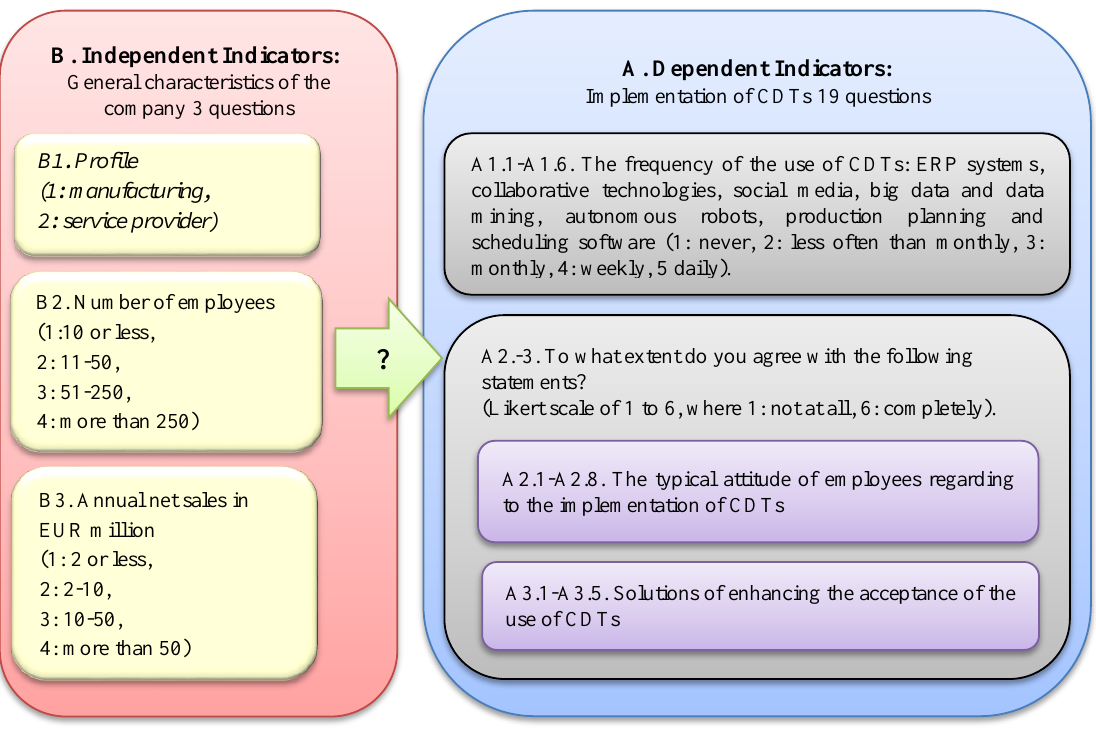
Figure 4. Research